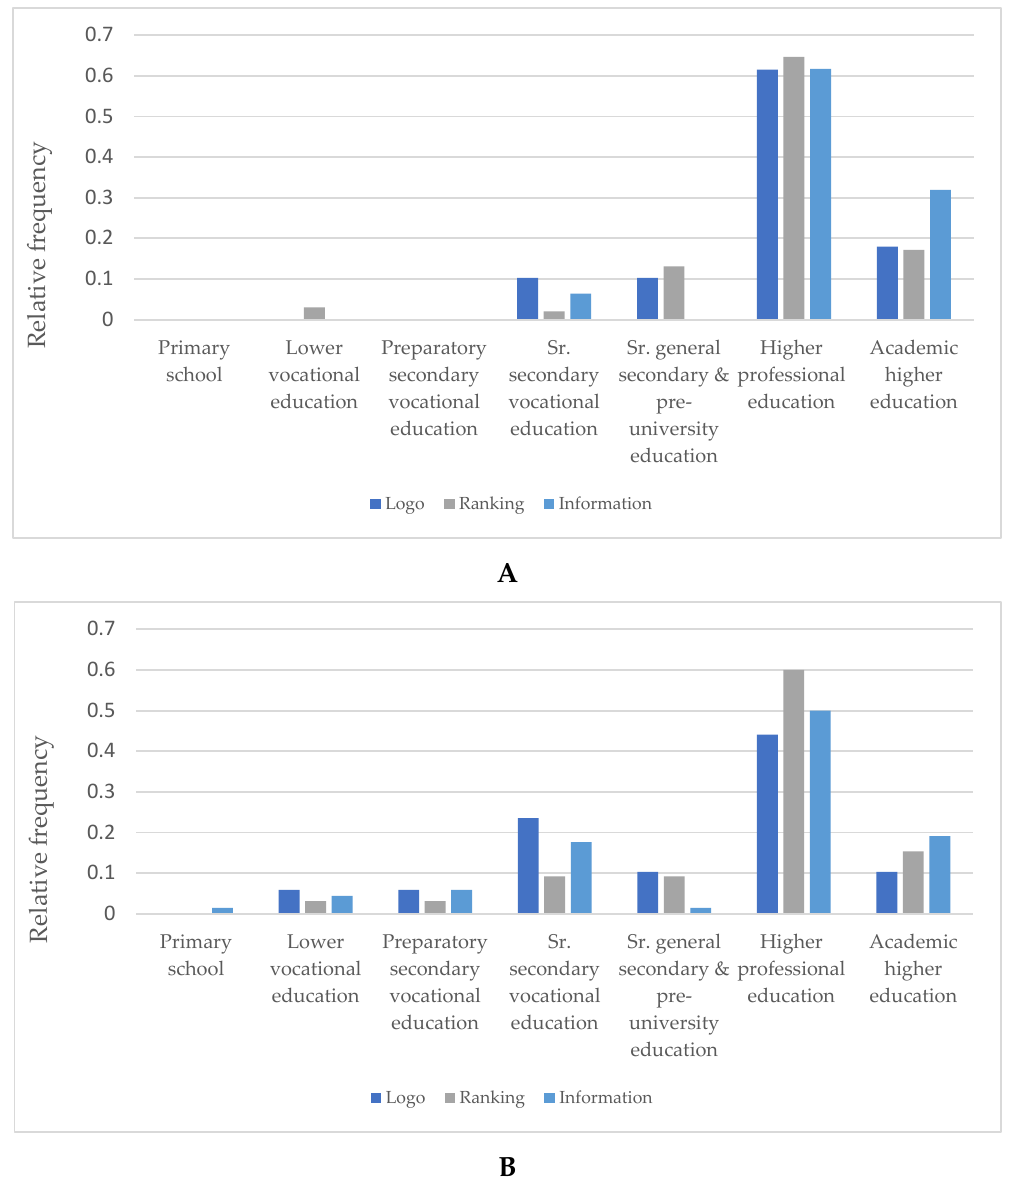
Figure 4. Relation of educational level of the (potential) restaurant guests (( A ) ≤ 30 years old, ( B ) >30 years old) with label preference (values are represented as relative frequencies) corrected for age.